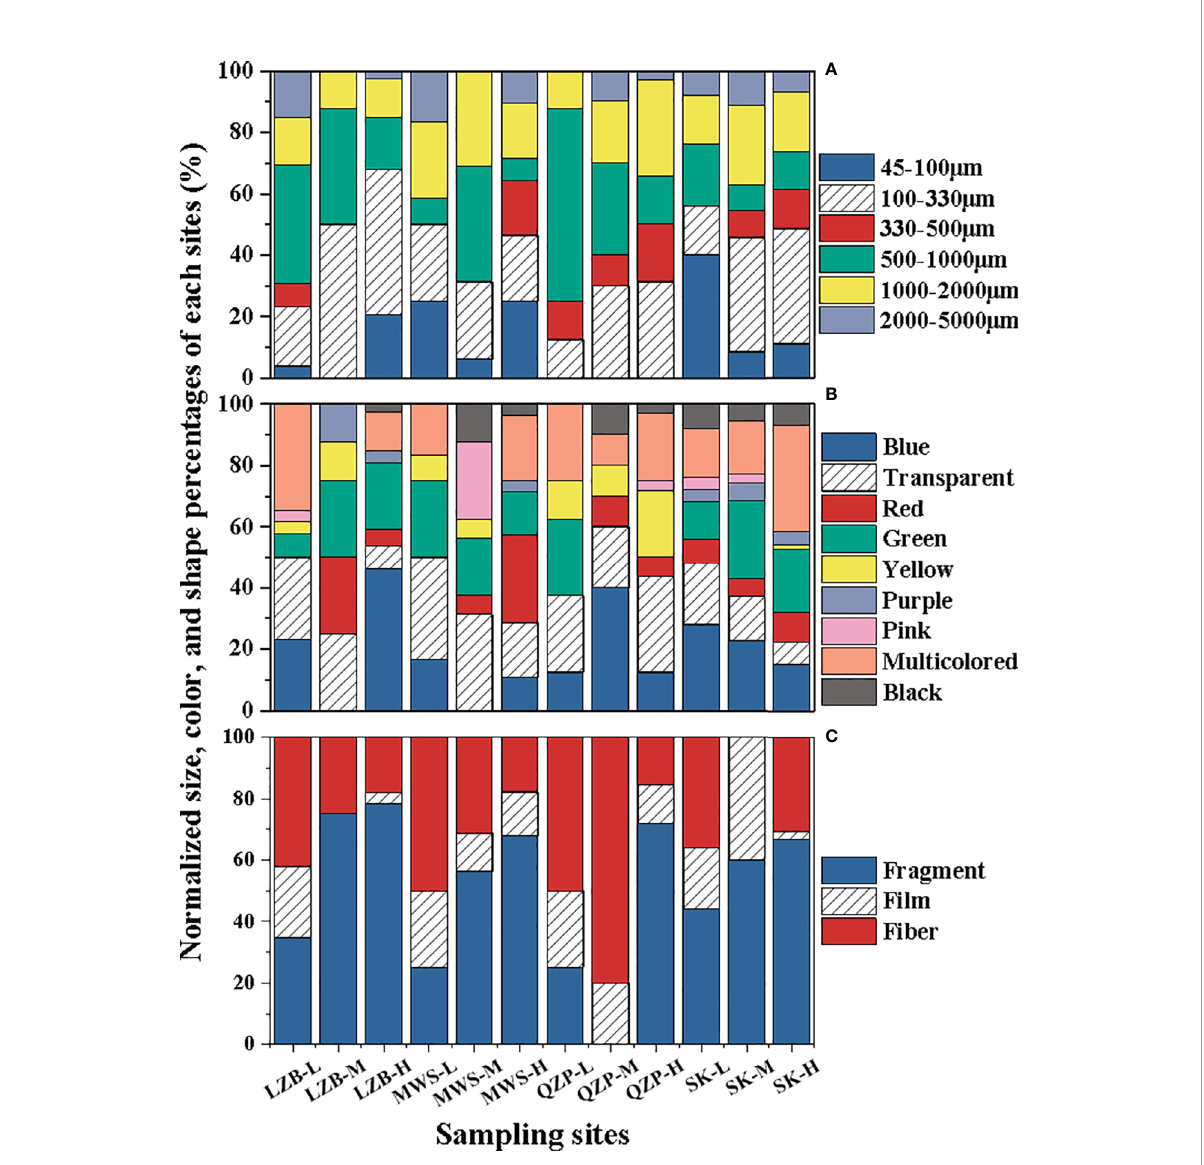
FIGURE 3 Characteristic percentage variation of microplastics (MPs) in mangrove forests (A) size, (B) color, and (C)